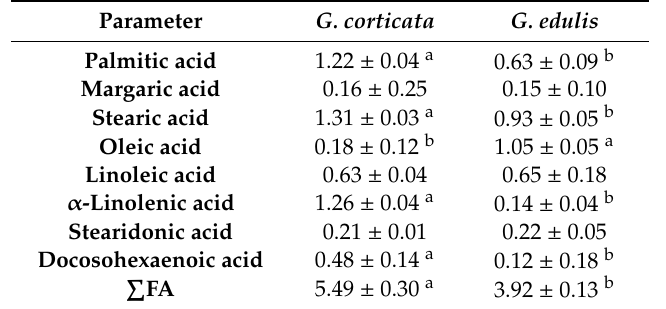
Table 2. Fatty acids profile (g fatty acid methyl esters / 100 g total fat) of G. corticata and G. edulis